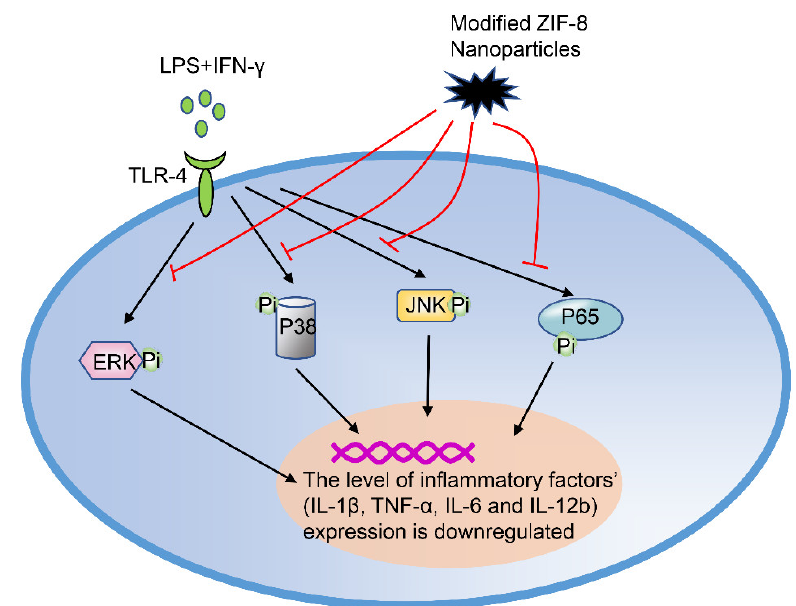
Figure 5. Modified ZIF-8 nanoparticles regulate the polarization of macrophages. In an inflammatory state, inflammatoryfactors(LPS + IFN- γ )causethephosphorylationofERK,JNK,p38, andp65, whichsubsequently activate the downstream signaling pathways respectively. However, the phosphorylation of these (p-ERK, p-p38,andp-p65)wasinhibitedbymodifiedZIF-8nanoparticles. LPS,lipopolysaccharide;IFN- γ ,interferon- γ ; ERK, extracellular regulated protein kinase; JNK, c-Jun N-terminal